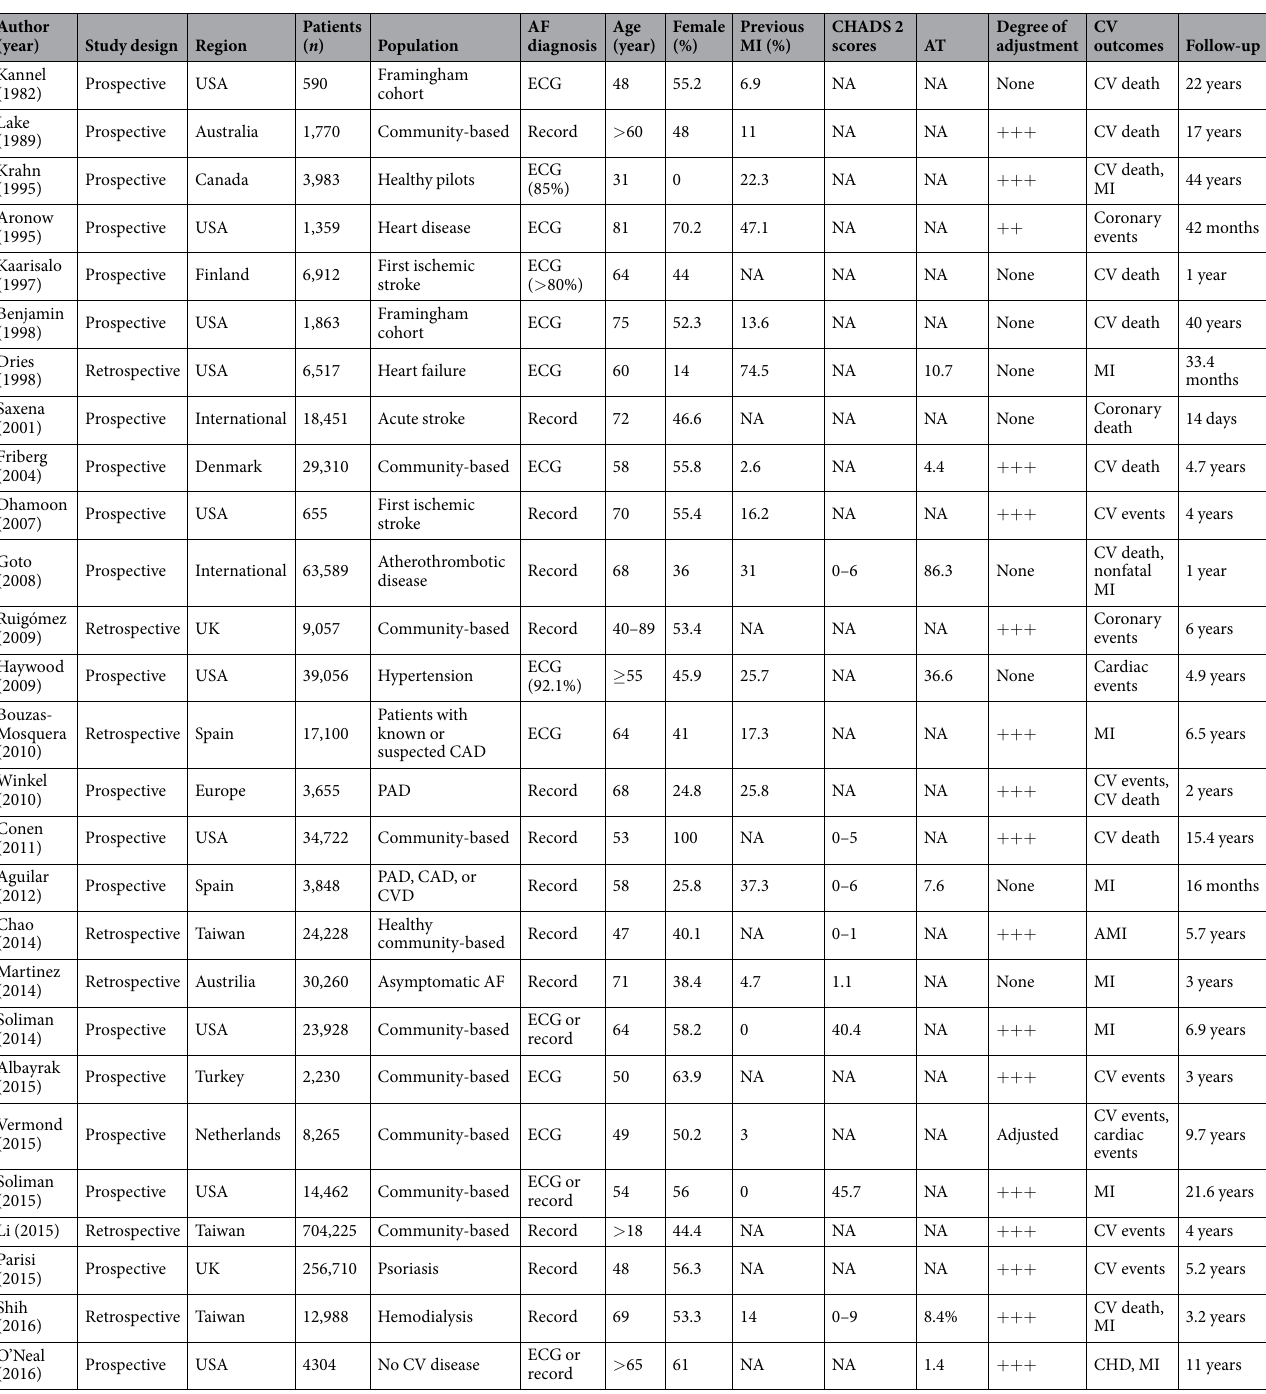
Table 1. Characteristics of included studies. AT, antithrombotic; ACM, all-cause mortality; CHD, coronary heart disease; CV, cardiovascular; CVD, cardiovascular disease; HF, heart failure; MI, myocardial infarction; NFMI, nonfatal MI; PAD, peripheral arterial